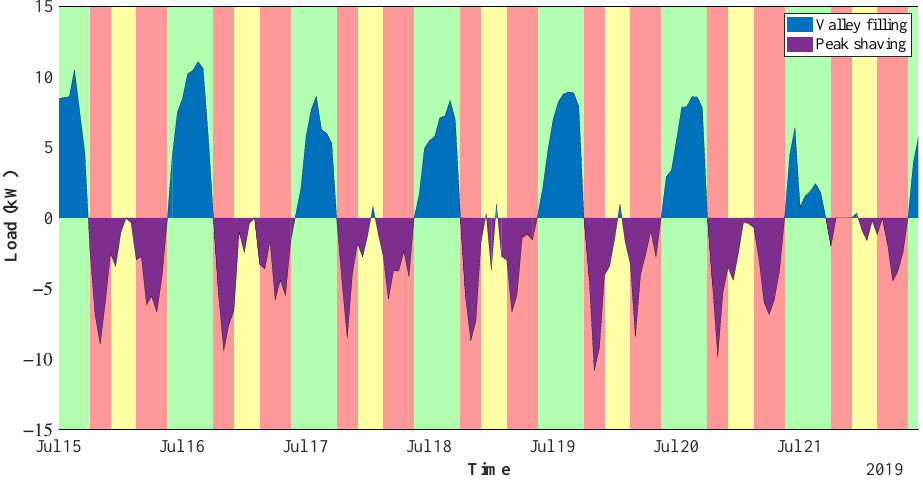
Figure 8. Load shifting in DR programme.